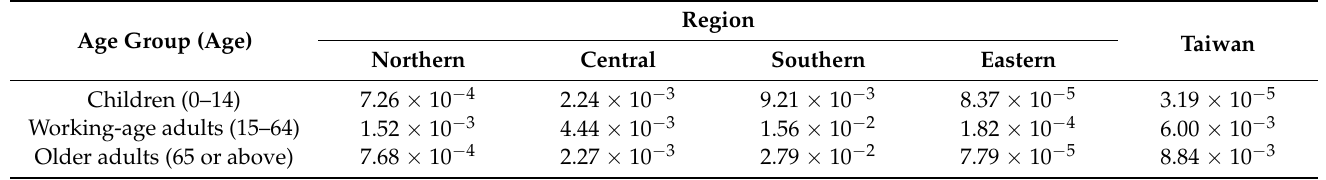
Table 2. LADD data for different age groups in different regions. Source: [53].